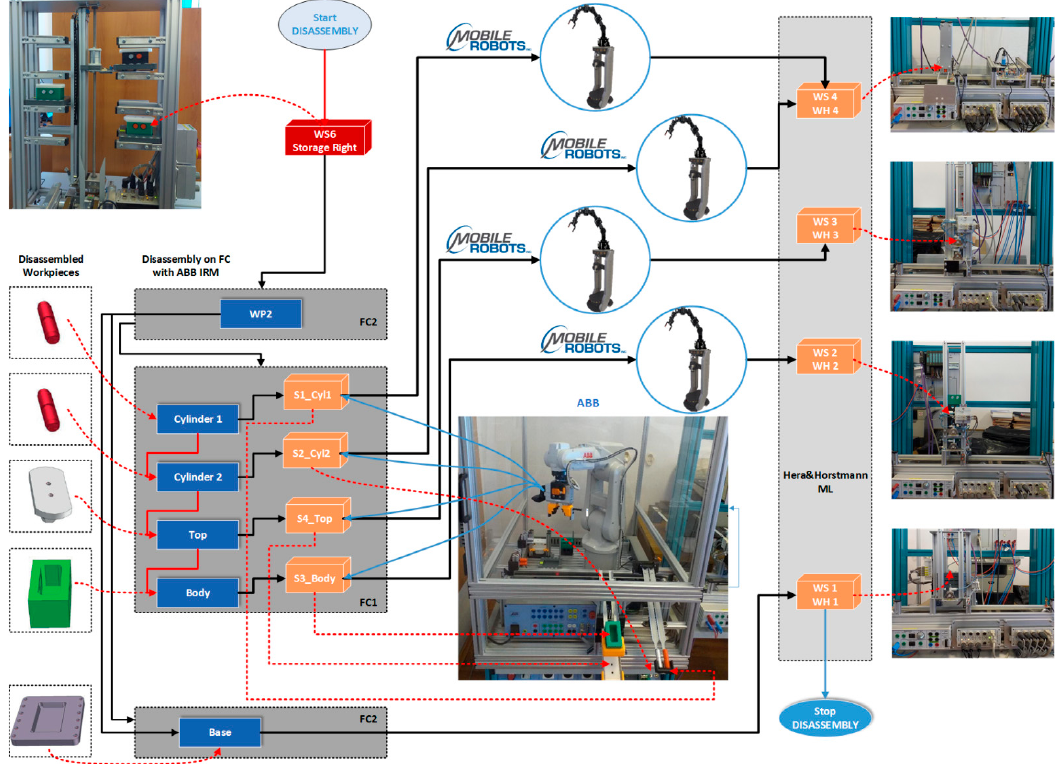
Figure 10. Task planning and synchronization for disassembly of the WP2 on FC with ABB IRM.